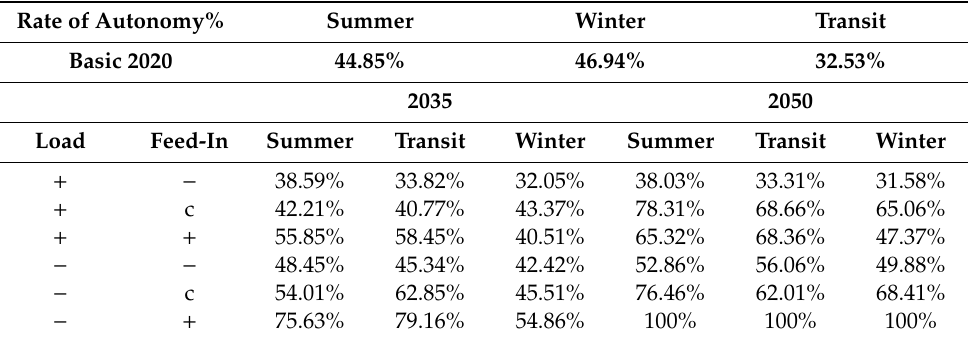
Table 7. Degree of autonomy for the di ff erent scenarios A p .